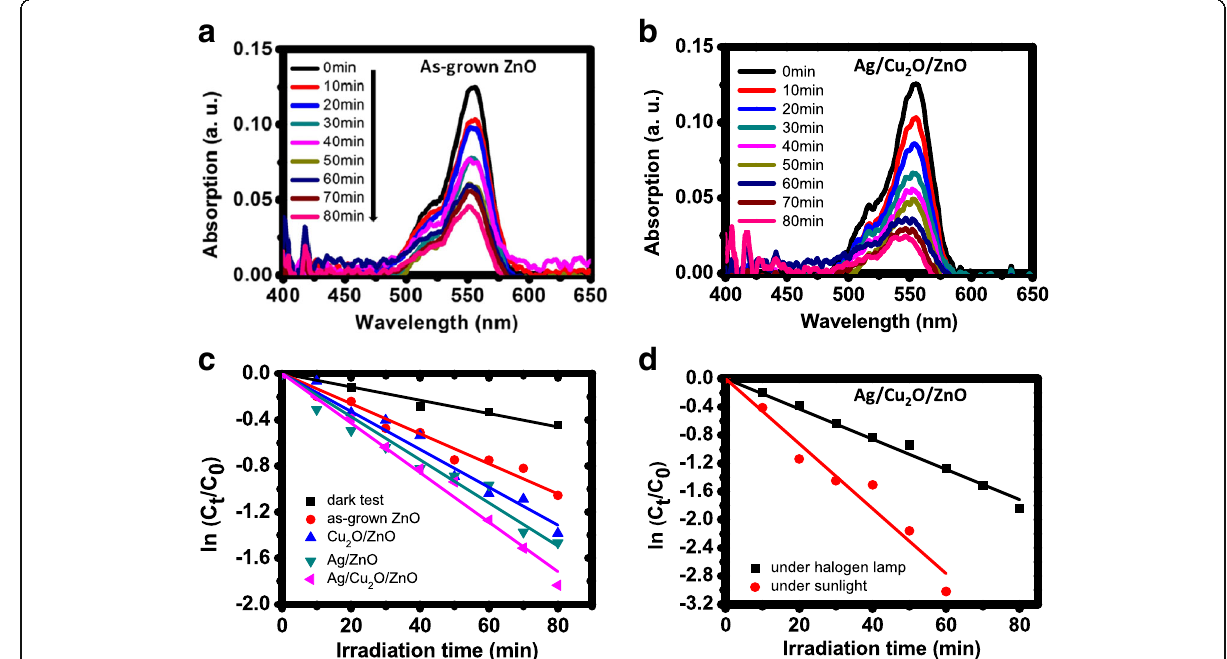
Fig. 7 a , b Absorption spectra of the RhB solution as a function of time (at a 10-min interval) resulting from the photocatalysis of the ZnO and the Ag/Cu 2 O/ZnO papers, respectively. c Plots of ln( C t / C 0 ) for the ZnO paper in the dark and the four photocatalytic papers under the light. d Plots of ln( C t / C 0 ) for the Ag/Cu 2 O/ZnO paper under the illumination of a halogen lamp and direct sunlight